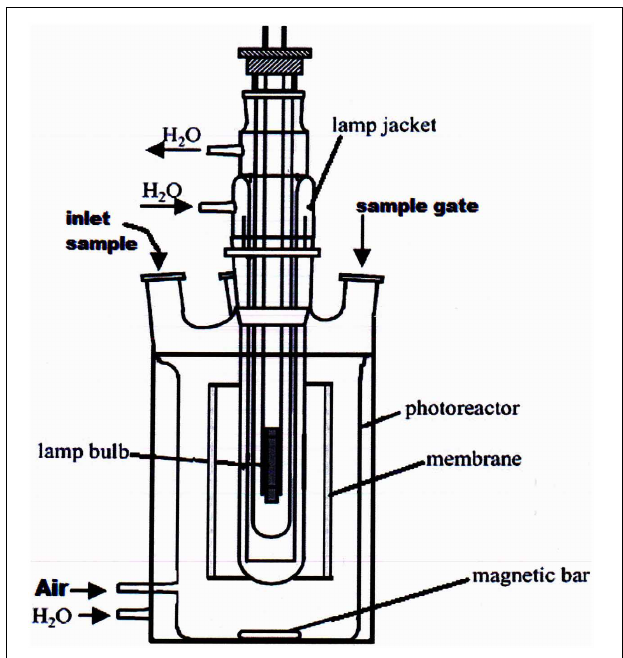
FIGURE 2 | Scheme of the batch photoreactor (1.5L) with the membrane placed around the bulb of the